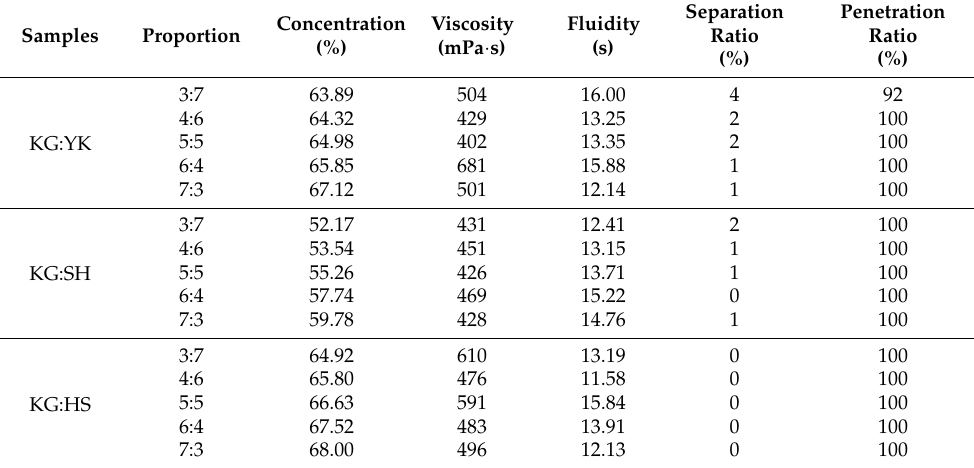
Table 7. Properties of CWS of KG coal with other three low rank